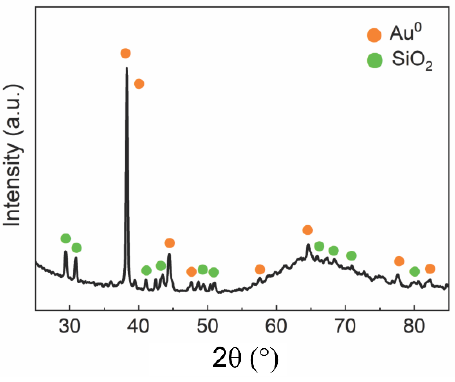
Figure 4. XRD patterns of interdigitated electrodes: Au 0 (conductor), SiO 2 (dielectric